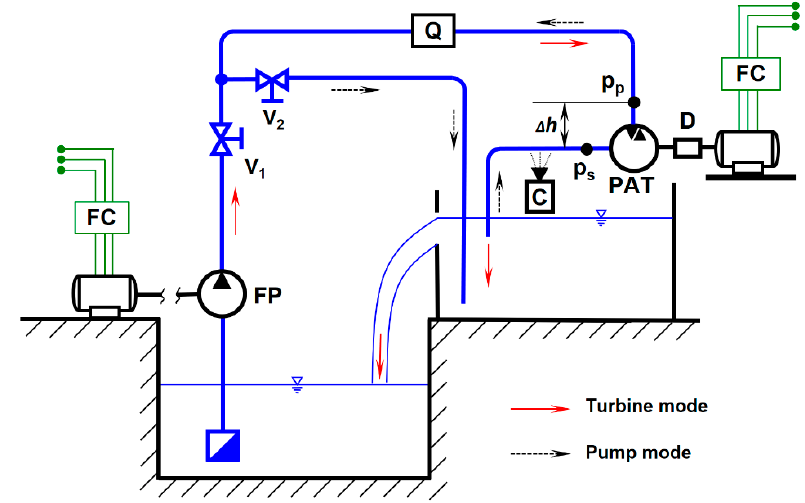
Figure 4. Hydraulic circuit scheme for testing turbines/pumps; Q, flowmeter; FP, feed pump; PAT,